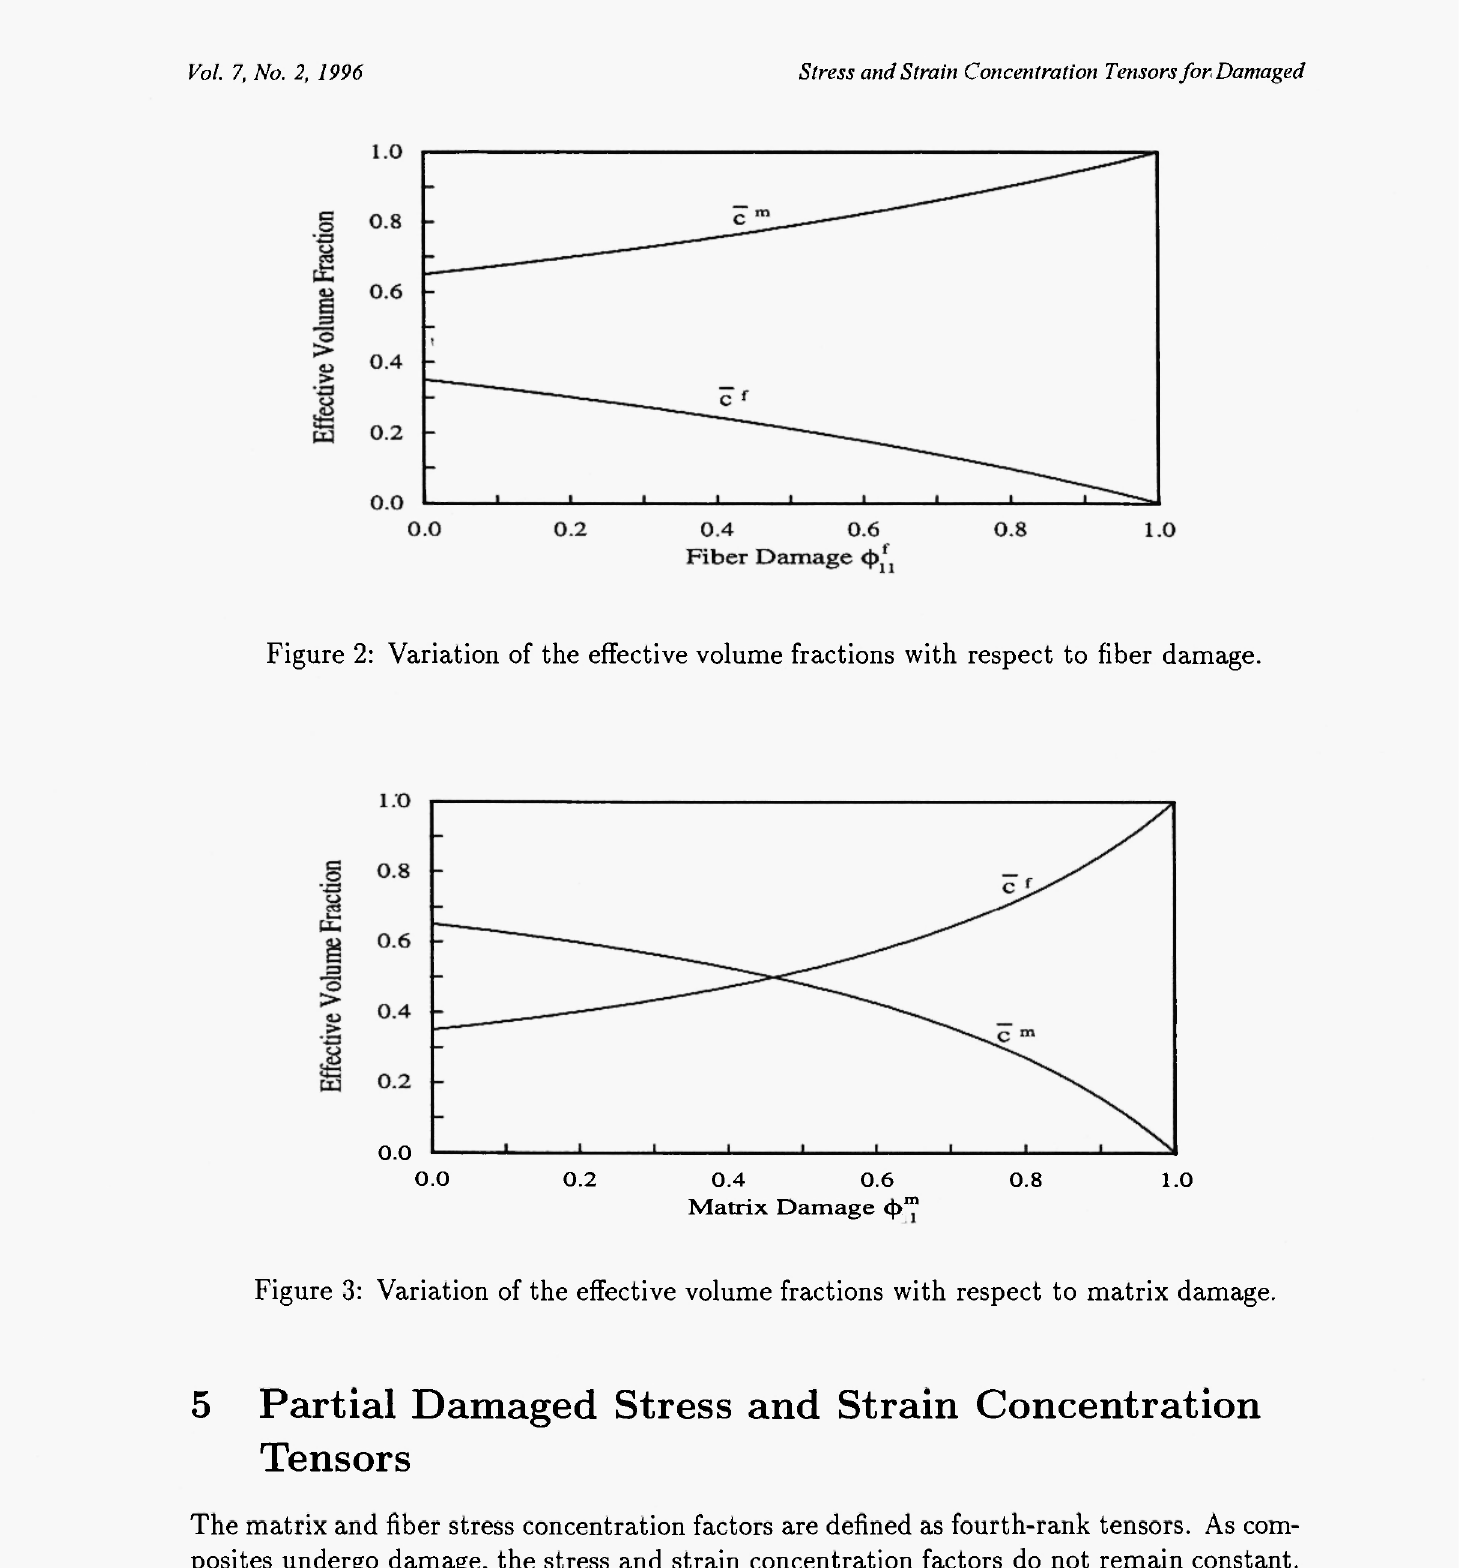
Figure 3: Variation of the effective volume fractions with respect to matrix